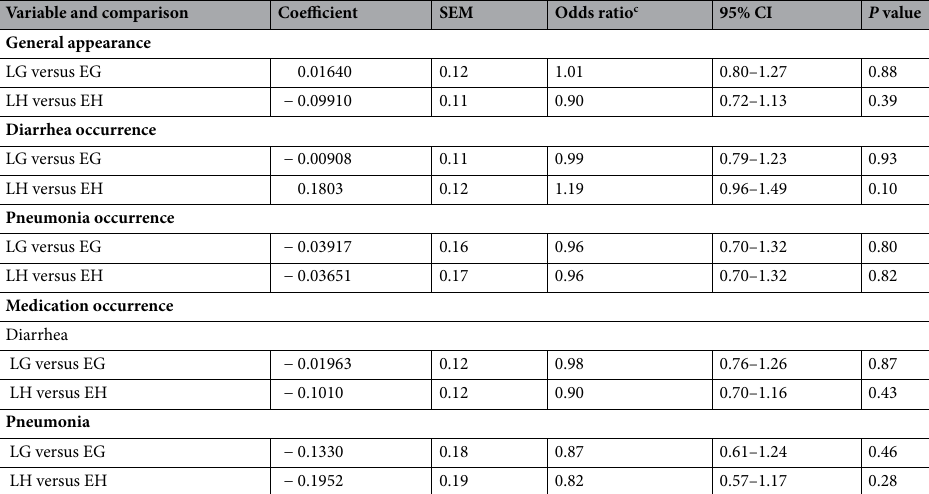
Table 3. Logistic model for general appearance ≥ 2, a diarrhea ≥ 3, b pneumonia, and medication occurrence during the overall (week 1–13) period as influenced by late grouping (LG) or early grouping (EG) and late hay increment (LH) or early hay increment (EH) to Holstein calves. a 1 = normal and alert; 2 = ears drooped; 3 = head and ears drooped, dull eyes, slightly lethargic; 4 = head and ears drooped, dull eyes, lethargic; 5 = severely lethargic 45 . b 1 = normal; 2 = soft to loose; 3 = loose to watery; 4 = watery, mucous, and slightly bloody; 5 = watery, mucous, and bloody 45 . c The odds ratio (OR) indicates the probability of having diarrhea or pneumonia, or needing medication for the experimental treatments (LG vs. EG; and LH vs. EH). If the OR is > 1, the treatment in the comparison is more likely to have diarrhea or pneumonia or to be medicated than the other treatment by a factor of the difference above 1. If the OR is < 1, the treatment has a lower probability of occurrence than the other